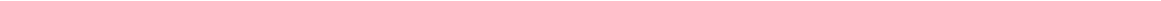
Fig. 4 Firing rates of neurons change according to different rules followed by the animal. a During a behavioural session, the animal successfully adjusted its performance during three different rules presented consecutively. Highlighted episodes represent the trials used to generate the representations of network states. b Projection of multi-unit activity ( n = 24 neurons) onto the two highest principal components for the session shown in ( a ). c Comparison between the performance of K-means clustering on the observed fi ring rates versus the performance of the k-means clustering on the shuf fl ed fi ring rates ( p = 2.95e − 5, Wilcoxon signed-rank. d Normalised distributions of the performance (shuf fl e data minus observed data) for each of the 26 sessions, using the centre of mass as a starting point of the k-mean clustering algorithm. The green line references performance of the observed data. Red circles denote outliers. Box plots show median, 25th and 75th percentile. e Three-dimensional plot of a multiple linear regression with the z-scored Euclidean distance between clusters as the dependent variable. The regressors are the number of trials in between and the number of rules in between. The plane is the resulting equation of the regression. Note that the distances are better explained by the rules ( p = 2.81e-08) than the number of trials ( p = 0.779) in between. f Partial correlation plots of the distance between the centre of masses of the rules and the number of trials taking into account the number of rules (left) and the distance between centre of masses of the rules and the number of rules taking into account the number of trials